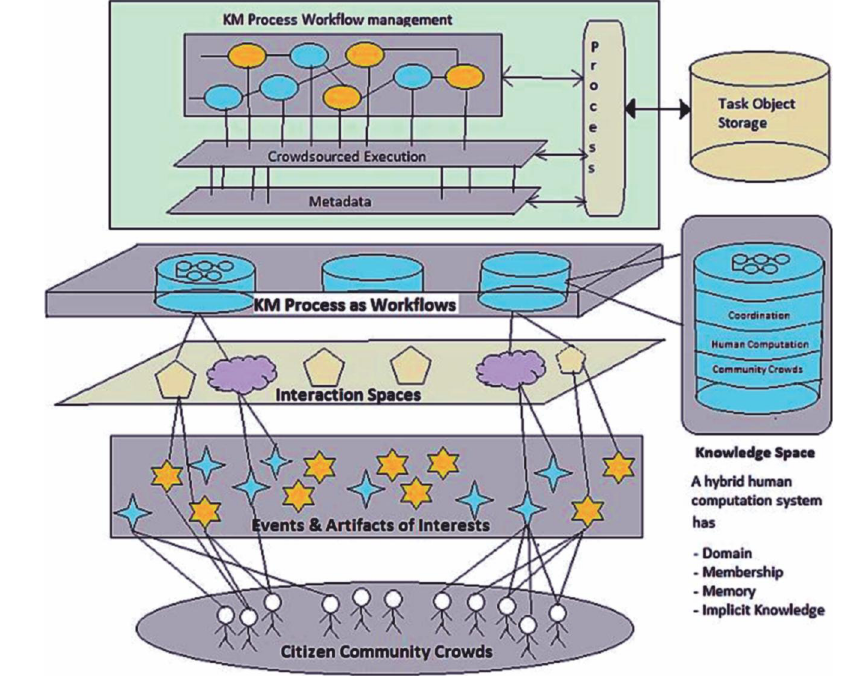
FIG. 2. KM FRAMEWORK FOR CITIZEN COMMUNITY